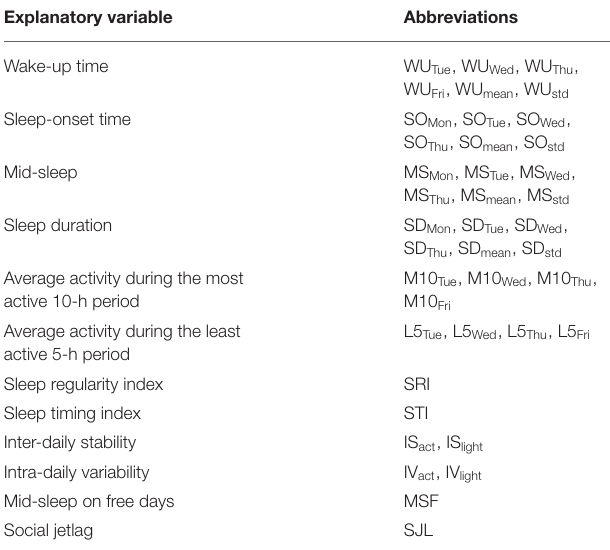
TABLE 1 | Measurements from actigraphy